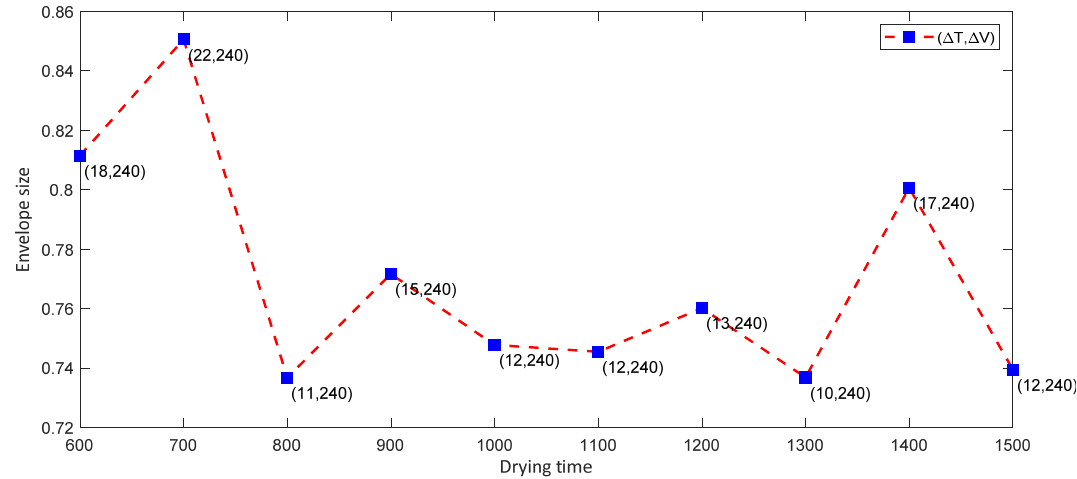
Figure 5. Result of a design selection by trade-off between envelope size and drying time.